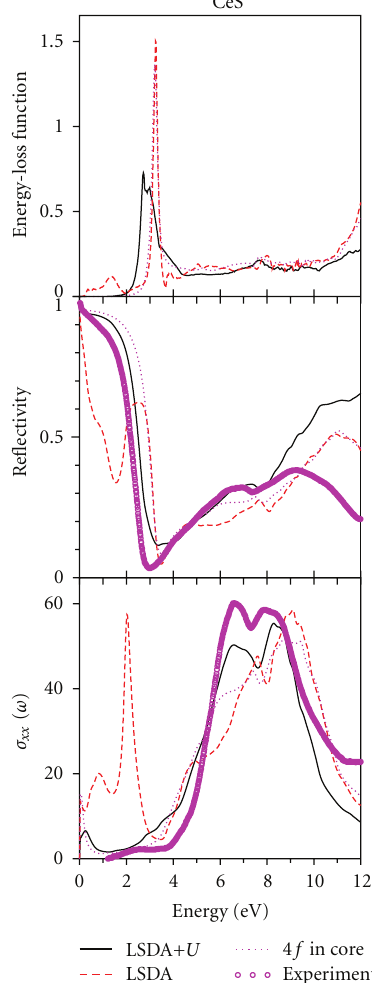
Figure 38: Calculated absorptive diagonal part of the optical conductivity σ 1 xx (in 10 14 s − 1 ), the optical reflectivity R , and energy- loss function of CeS [261] compared with experimental data